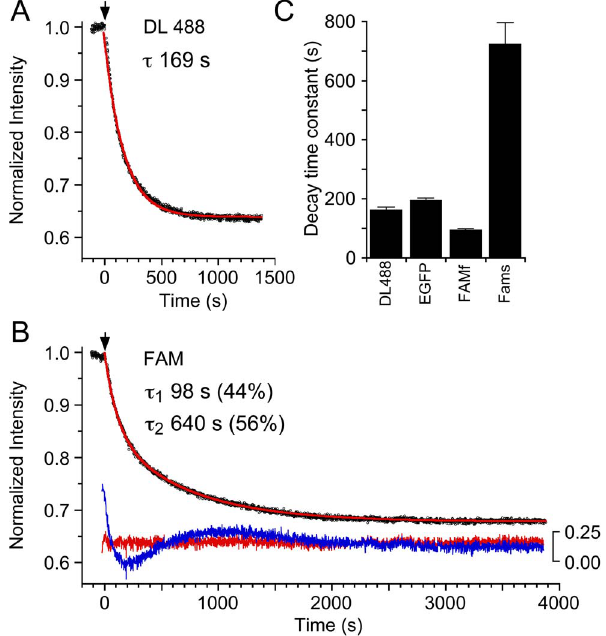
Figure 6. Analysis of GluA2 ATD dimer dissociation kinetics measured by FRET. (A) Decay of emission at 603 nm after addition of 1 m M unlabeled GluA2 (arrow) to a pre-equilibrated mix of 50 nM Dylight488-GluA2 ATD and 50 nM AF568-GluA2 ATD; the red line shows a single exponential fit of time constant 169 s, with decay to 64% of the initial amplitude. (B) Decay of emission at 603 nm after addition of 1 m M unlabeled GluA2 (arrow) to a pre-equilibrated mix of 50 nM FAM-GluA2 ATD and 50 nM AF568-GluA2 ATD; the red line shows a double exponential fit of time constant 98 s (44%) and 640 s (56%), with a total decay to 68% of the initial amplitude; the lower pair of red and blue lines show residuals on an expanded scale for double ( x 2 18.2 6 10 2 3 ) and single ( x 2 82.1 6 10 2 3 ) exponential fits, respectively. (C) Bar plot summarizing mean decay time constants for AF568-GluA2 FRET signal after addition of 1 m M unlabeled GluA2 ATD with either Dylight488- GluA2 ATD, EGFP-GluA2 ATD, or FAM-GluA2 ATD as the FRET donor; error bars show SD (n=3).